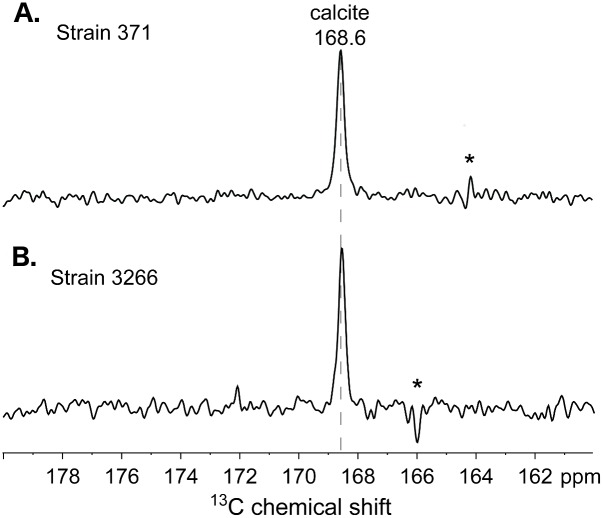
Solid-state 13C NMR.1D single-pulse 13C MAS NMR spectra of E. huxleyi strains (A) CCMP371 and (B) CCMP3266 acquired at 11.7 T, 25°C, and 10 kHz MAS. The asterisks indicate a frequency artifact corresponding to the 13C excitation pulse used in the experiment.